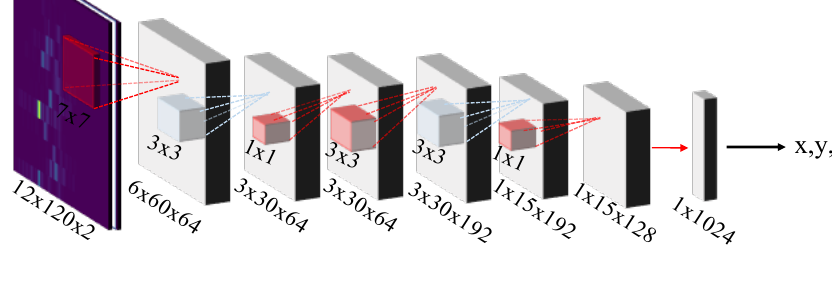
Figure 10. SmallNet